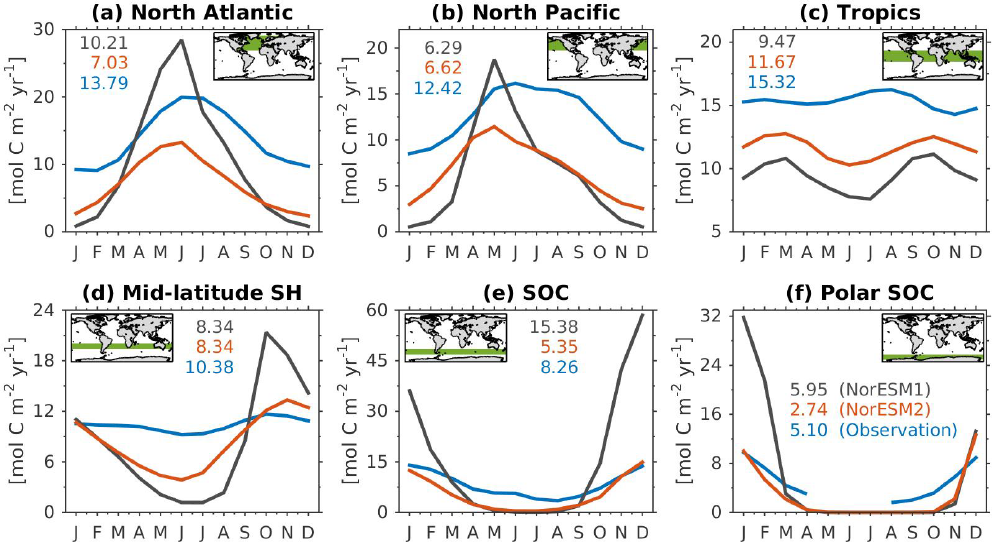
Figure 14. Mean seasonal cycle of vertically integrated contemporary primary production in the (a) North Atlantic (north of 20 ◦ N), (b) North Pacific (north of 20 ◦ N), (c) tropics (20 ◦ S–20 ◦ N), (d) mid-latitude Southern Hemisphere (20 ◦ S–40 ◦ S), (e) Southern Ocean (40 ◦ S–60 ◦ S), and (f) polar Southern Ocean (south of 60 ◦ S). Shown are values from NorESM1-ME (black), NorESM2-MM (red), and observational estimates (blue). Numbers within each panel depict the regional mean values averaged over all